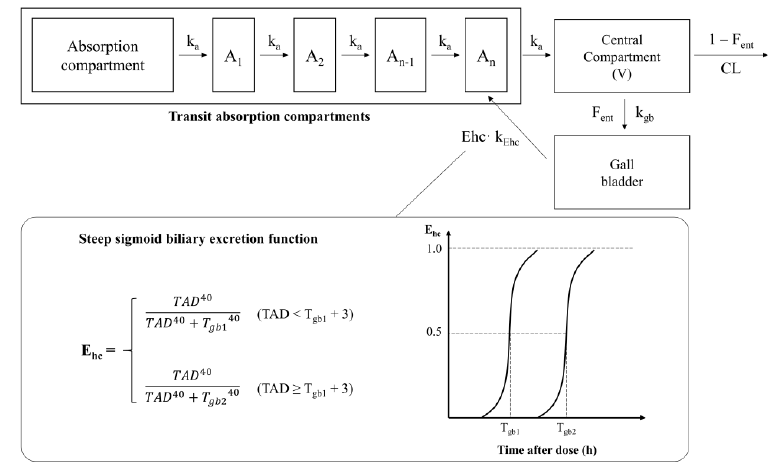
Figure 3. Structure representation of the final model. (k a , absorption rate constants; CL, clearance of the central compartment; V, volume of distribution of the central compartment; F ent , fraction of enterohepatic reabsorption; k Ehc , enterohepatic reabsorption constant; T gb1 , early gall bladder emptying time; T gb2 , late gall bladder emptying time).